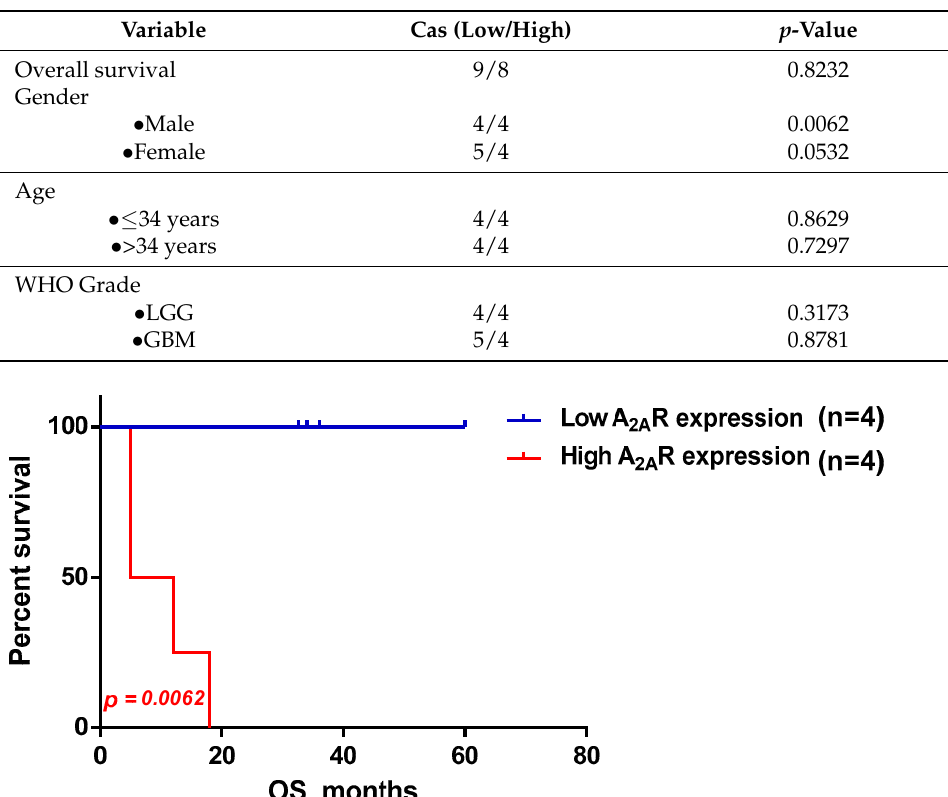
Table 2. A 2A R gene expression was associated with worse survival in Moroccan male patients.